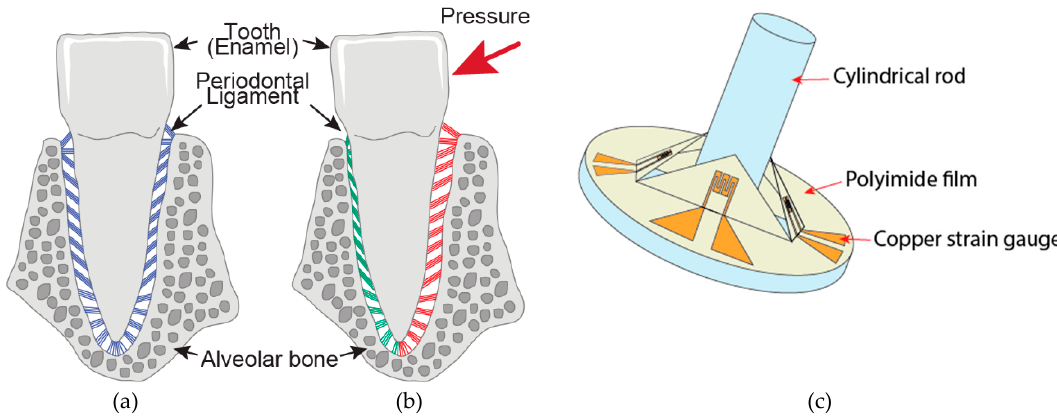
Figure 1. Movement of the periodontal ligaments beneath a tooth ( a ) in resting state and ( b ) with pressure applied. The green and red ligaments indicate compressed and stressed states, respectively. ( c ) Schematic image of the tooth-inspired tactile sensor.